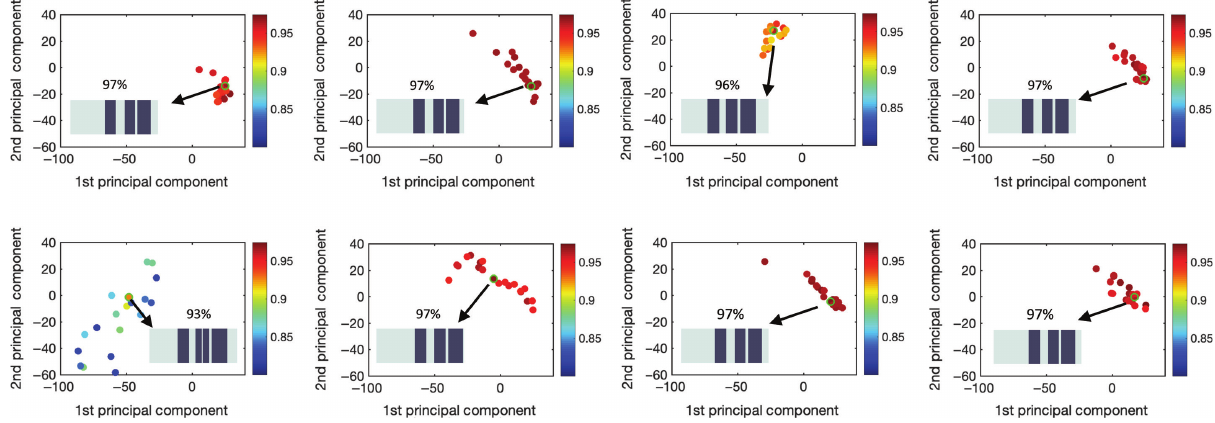
Figure 6: PCA visualization of GLOnet-optimized devices. Eight unconditional GLOnets are trained independently, and the top 20 devices of each GLOnet are visualized. The pattern and efficiency of the best device in each plot are shown as